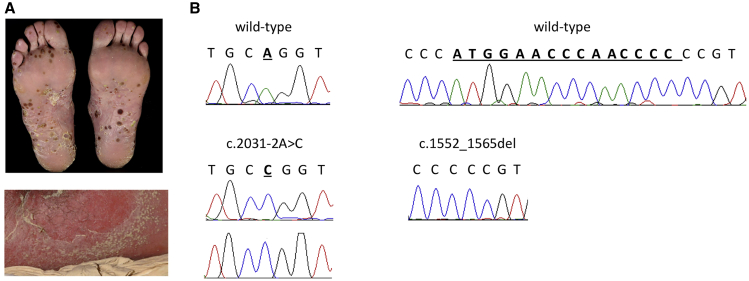
MPO Mutations Are Associated with Pustular Skin Disease(A) Typical presentation of generalized pustular psoriasis (bottom panel, showing skin pustulation on an erythematous background) and acral pustular psoriasis (top panel, showing neutrophil-filled pustules affecting the soles).(B) Validation of the disease alleles identified by whole-exome sequencing. The chromatograms show the c.2031−2A>C substitution observed in the GPP and APP subjects (left) and the c.1552_1565del deletion detected in a study participant with AGEP (right). The position of disease alleles is highlighted by bold, underlined font. Sanger sequencing could not be carried out in the c.2031−2A>C;c.1705C>T individual as no DNA was left for this subject.